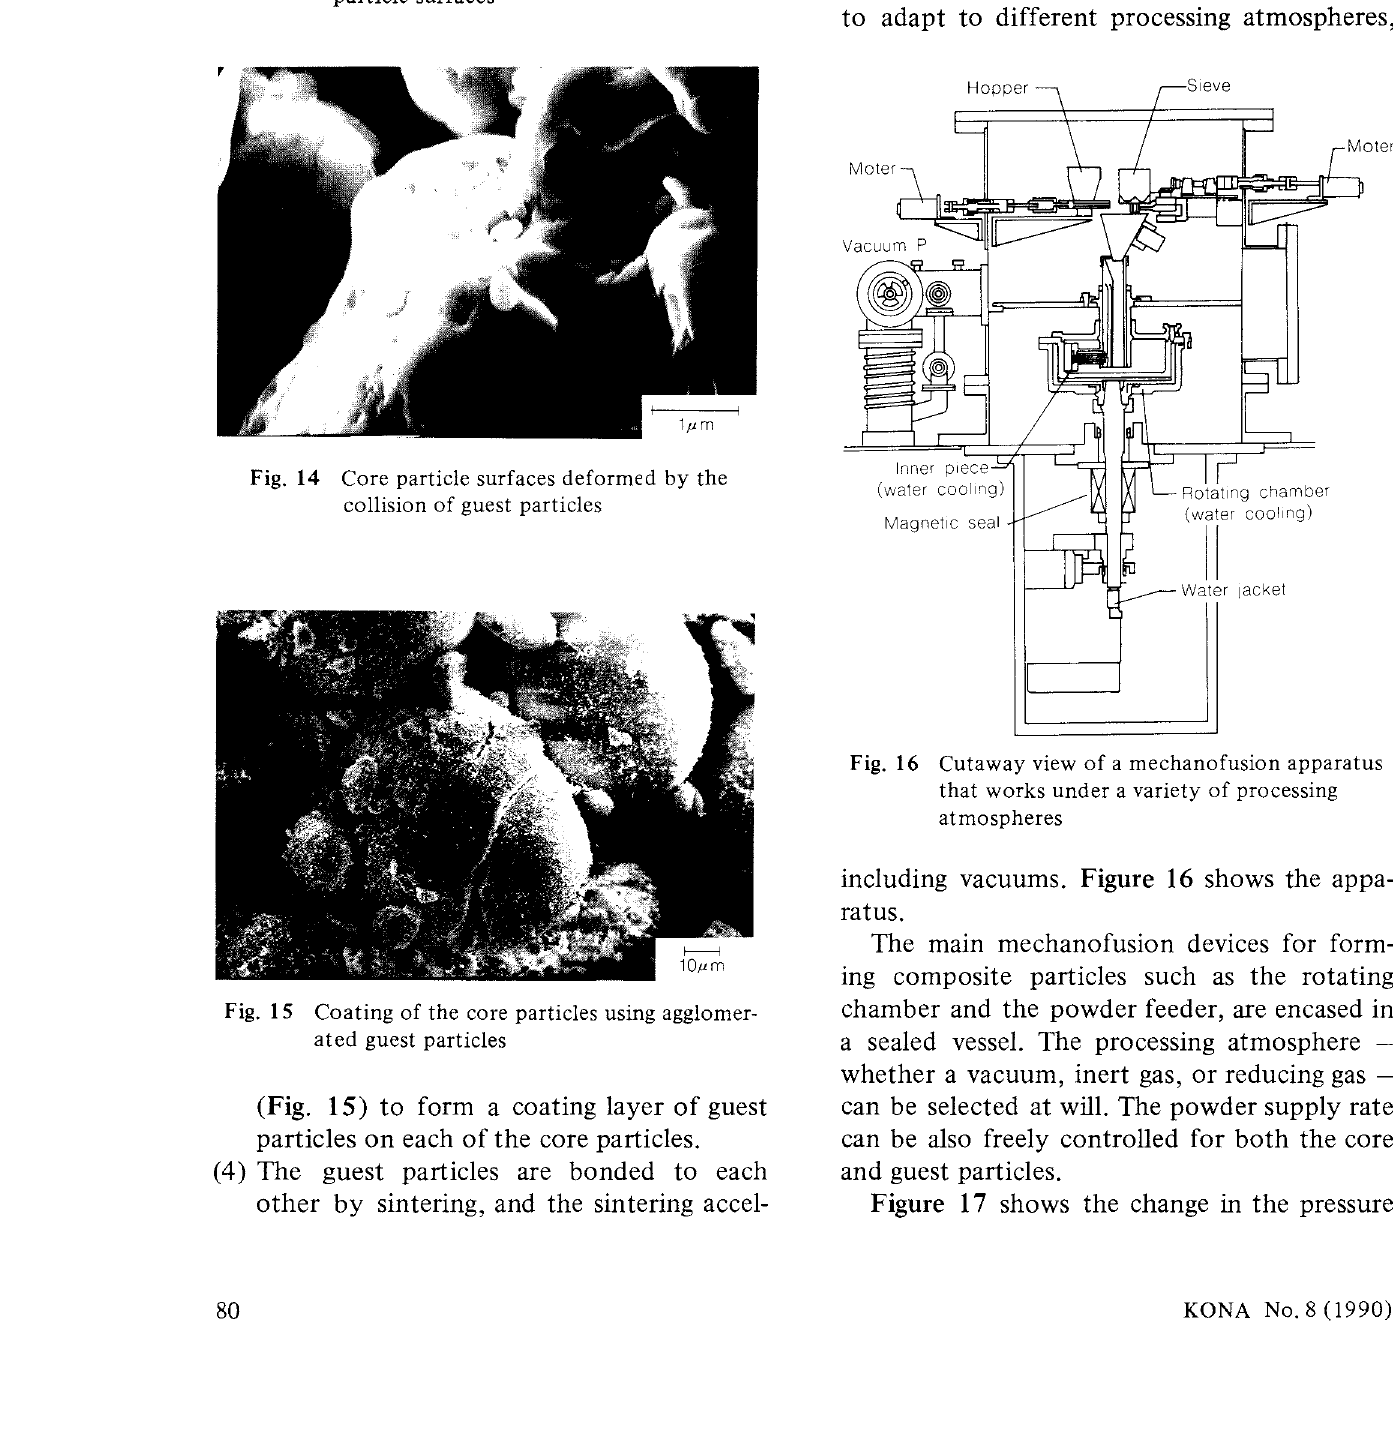
Fig. 13 Guest particles embedded in the core particle surfaces